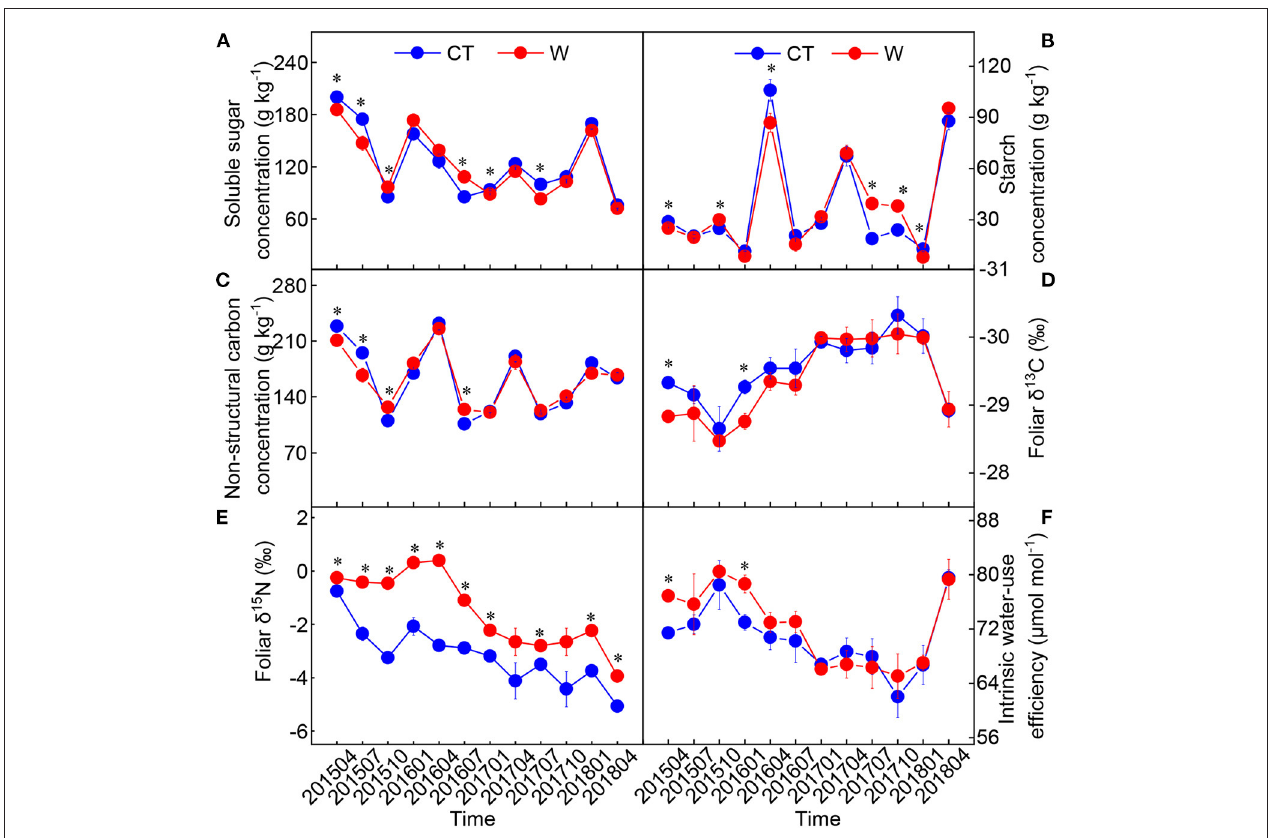
FIGURE 4 | Changes in foliar soluble sugar (A) , starch (B) , total non-structure carbohydrate (C) , δ 13 C (D) , δ 15 N (E), and intrinsic water use efficiency (F) in Cunninghamia lanceolata between warming (W) and control (CT) (mean ± standard error, n = 5). *Above the dot indicates a significant difference between warming and control treatments at the level of p <